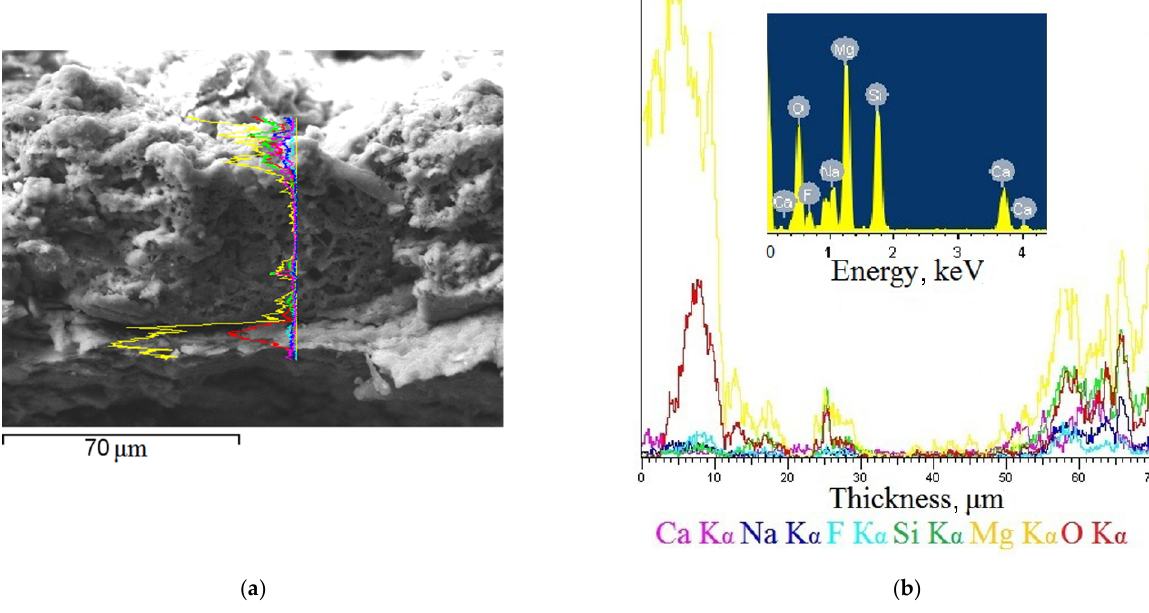
Figure 5. SEM image of the cross-section of the W-coating deposited at 450 V ( a ), element distribution tracks through the W-coating’s thickness ( a , b ), and the energy spectrum ( b ). Table 1. The elemental composition of the W-coatings on Mg0.8Ca is determined by the EDX method. Content of Elements (at. %) Elements